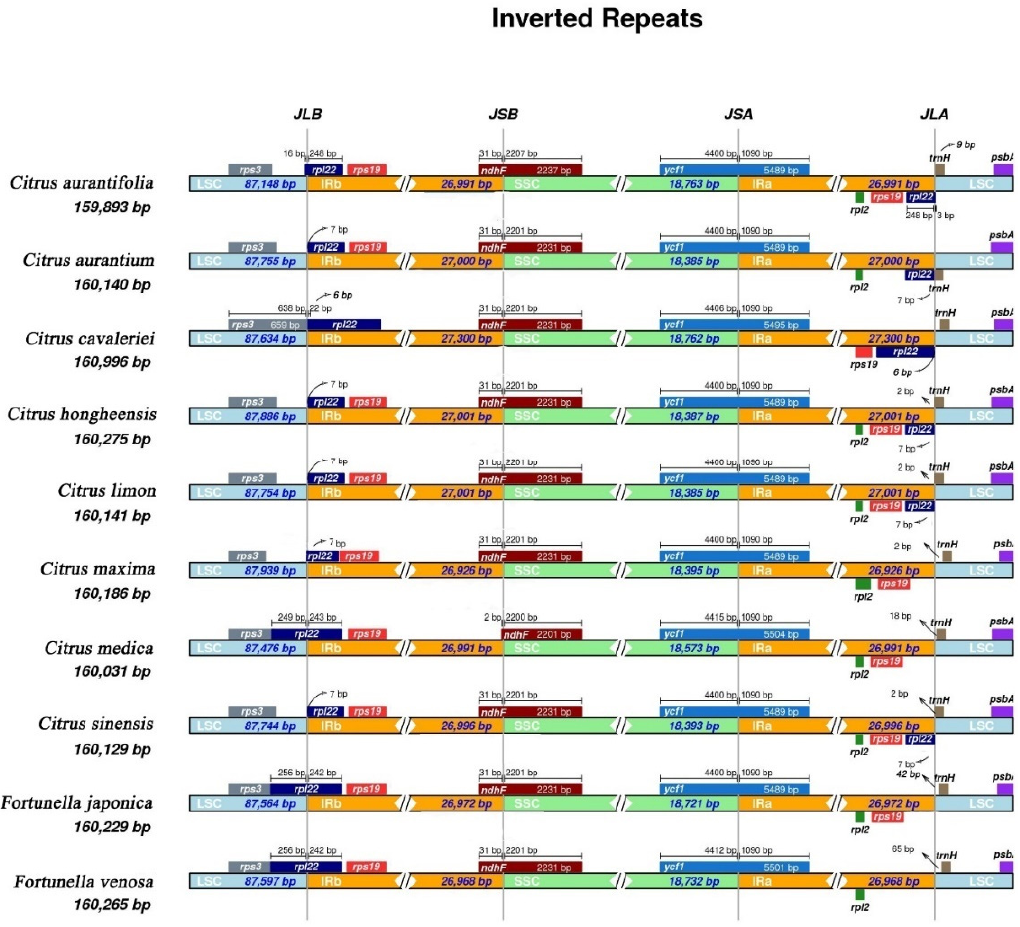
Figure 7. Comparison of border distances between adjacent genes and junctions of LSC, SSC, and two IR regions among chloroplast genomes of the ten Rutaceae species. Boxes above or below the main line indicate the adjacent border genes. The figure is not to scale with regard to sequence length and only shows relative changes at or near IR/SC borders.